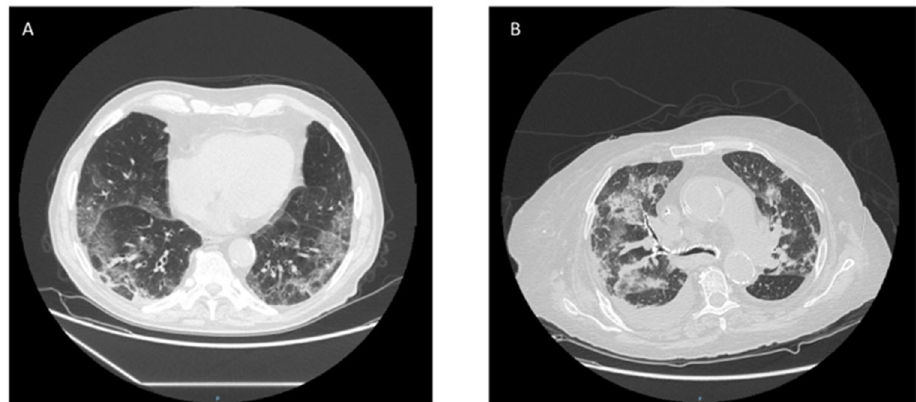
Figure 1. ( A ) HRCT (patient 1): Bilateral parenchymal thickening with predominantly ground-glass density. ( B ) HRCT (patient 2): Multiple areas of parenchymal lung thickening such as ground glass, bilaterally and ubiquitously